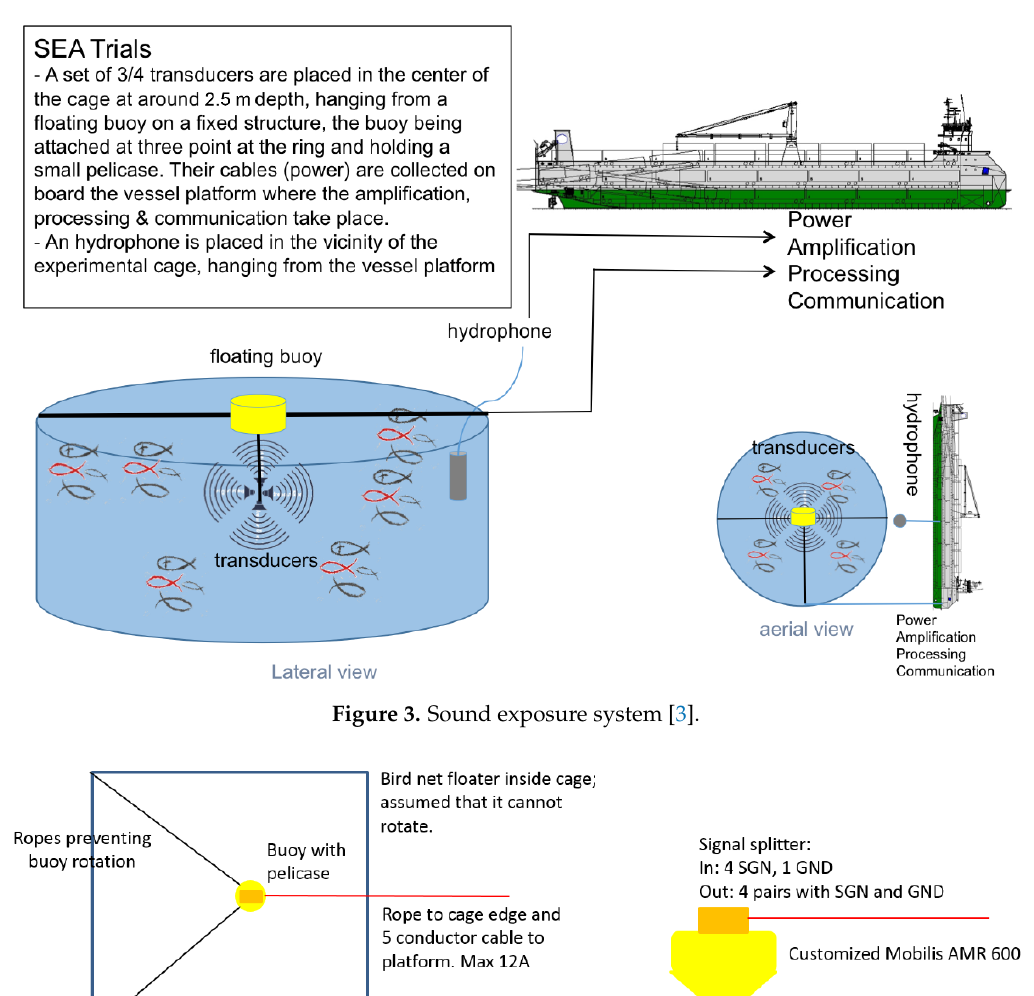
Figure 3. Sound exposure system [3].